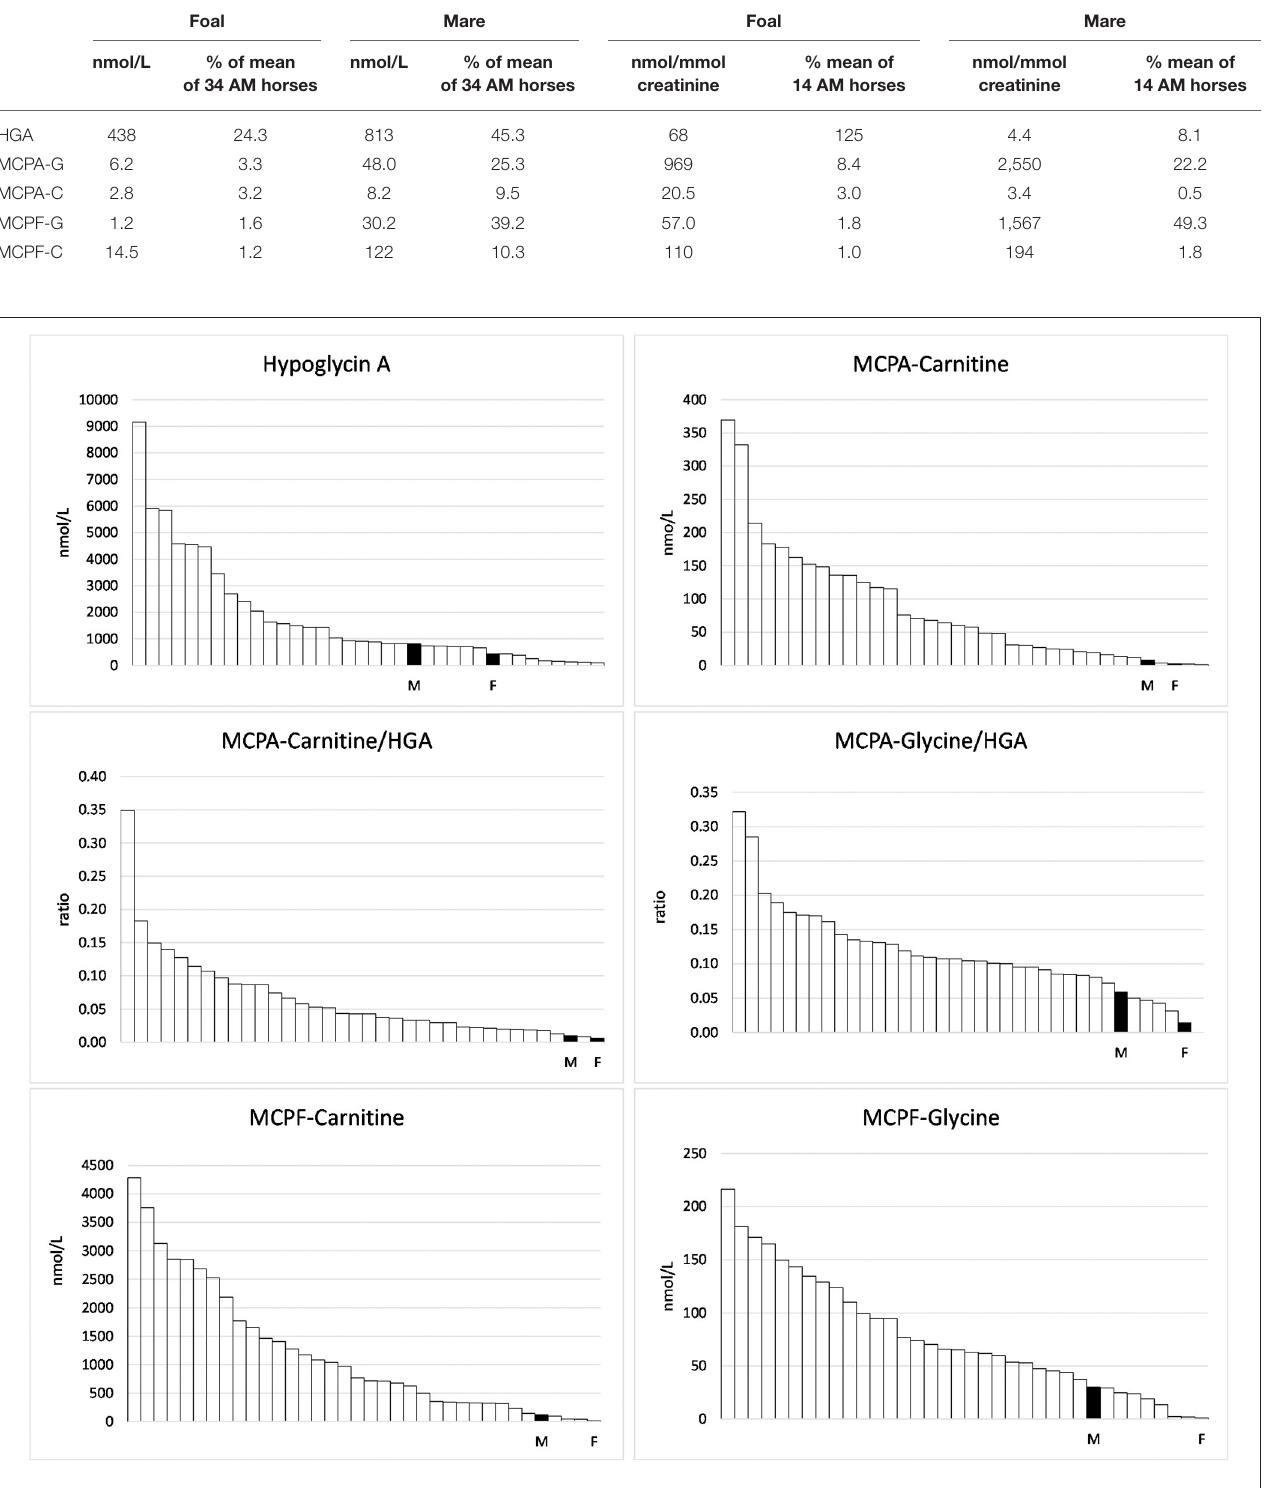
Frontiers in Veterinary Science |